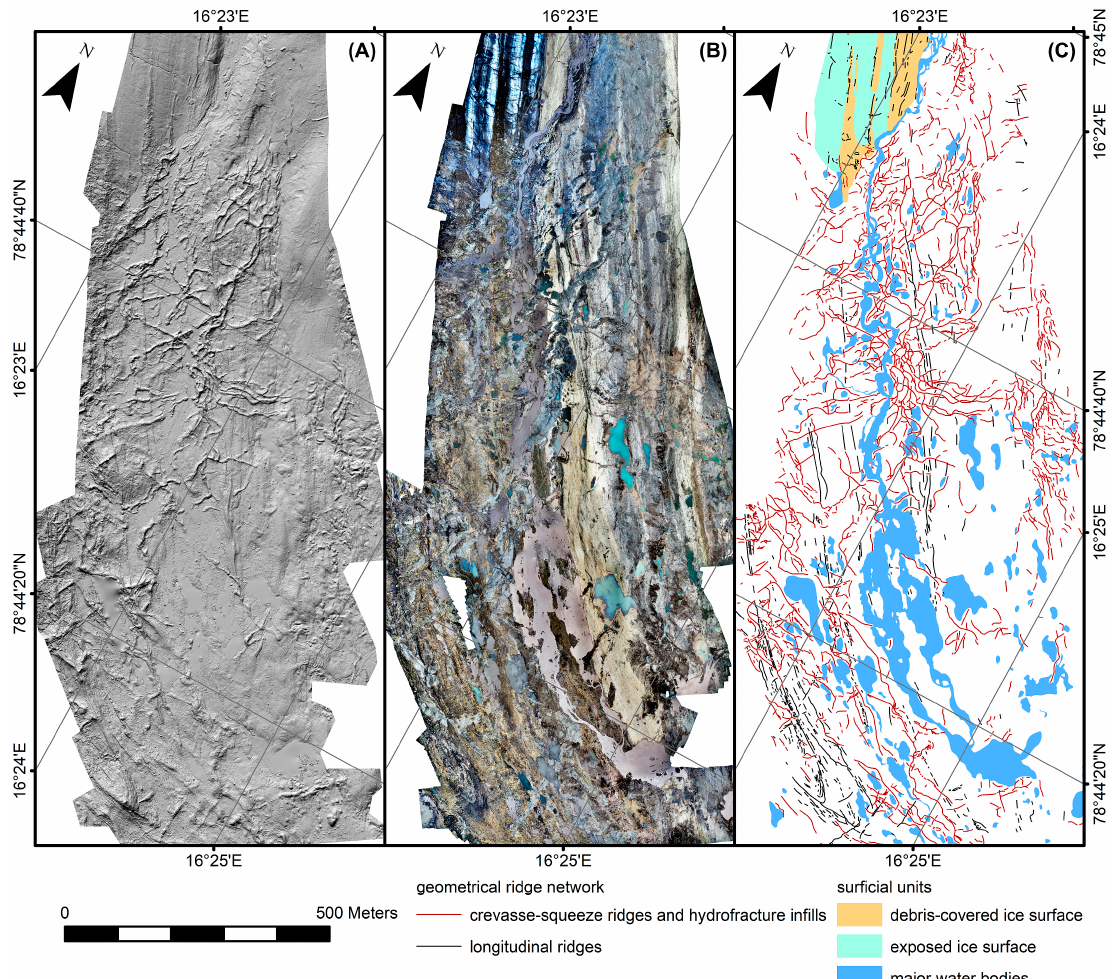
Figure 6. Distribution of the geometrical ridges in front of Horbyebreen, Svalbard. ( A ) Hillshade model; ( B ) Orthomosaic; ( C ) Geomorphological map showing complex pattern of cross-cutting ridges. Note, that it was necessary to combine both, DEM and orthomosaic, for proper interpretation and mapping of the ridges.